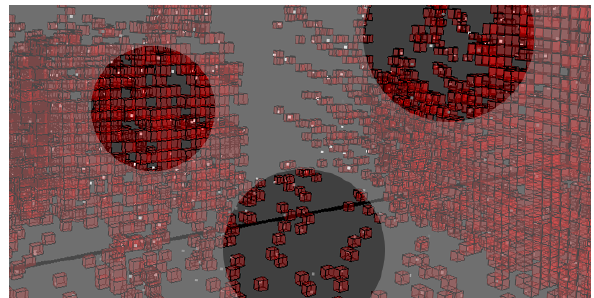
Figure 4. Whenever the environment is insufficiently sampled by the laserscanner, holes appear in occupancy grids of high resolution.